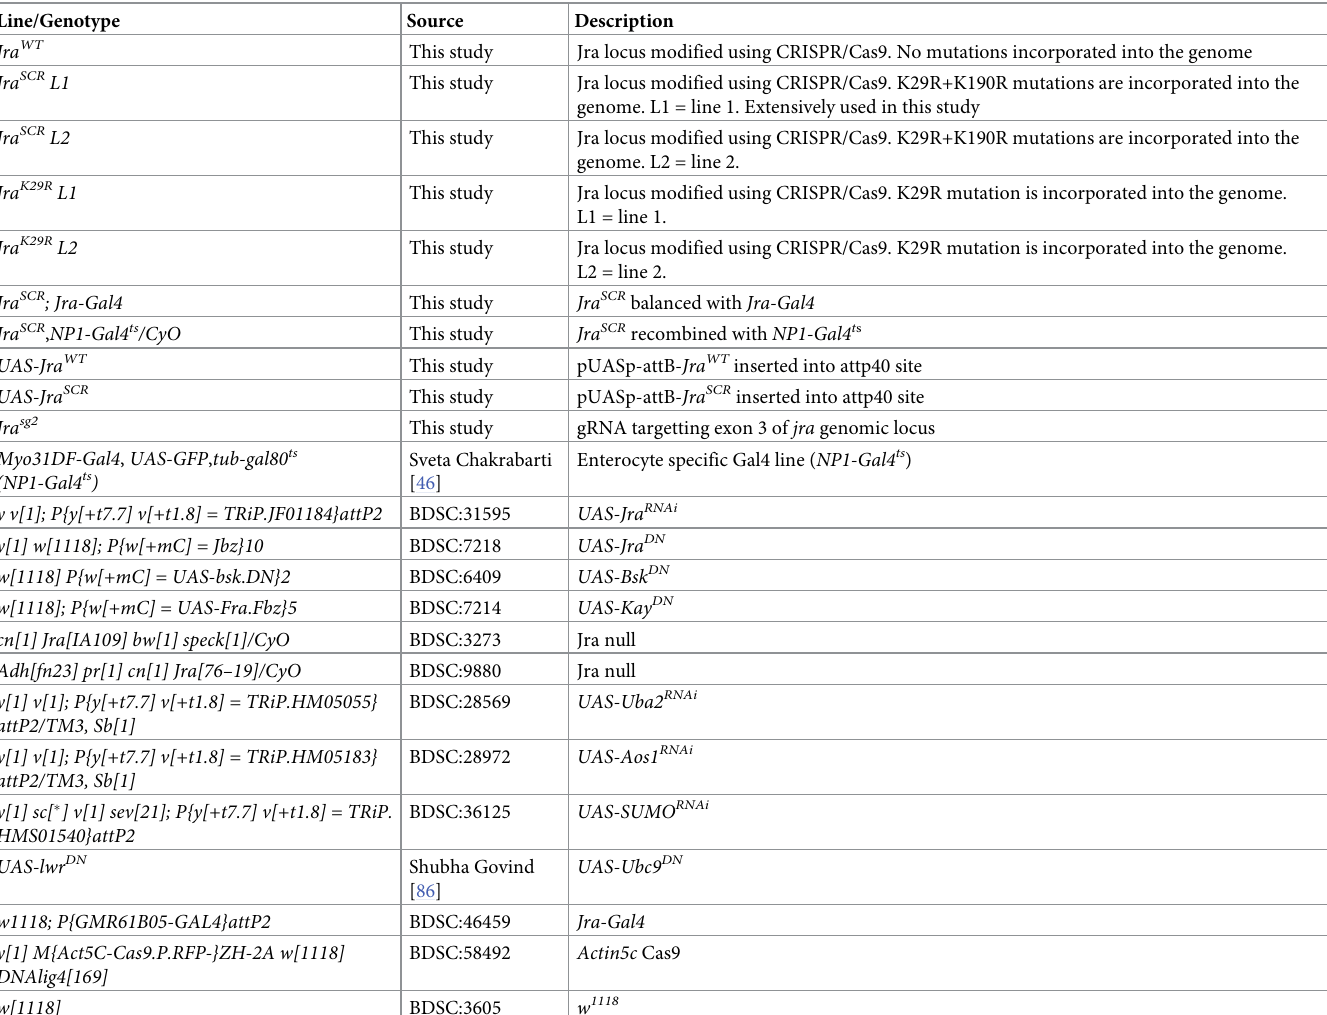
Table 1. Genotypes and source of Drosophila lines used for our